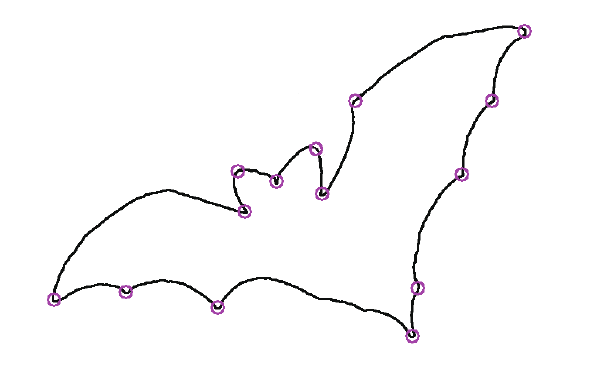
Figure 3. Contour segmentation by corner.